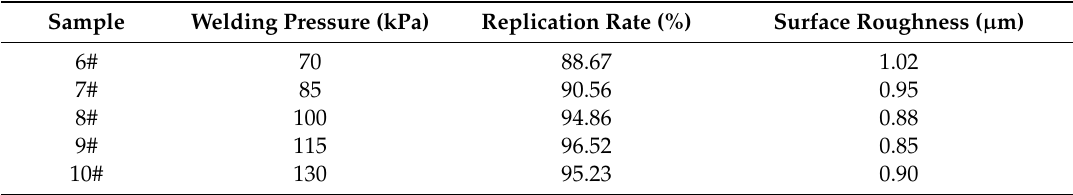
Figure 6. The replication rate of micro-structure at di ff erent welding pressures and three-dimensional profile: ( a ) 70 kPa; ( b )85 kPa; ( c ) 100 kPa; ( d ) 115 kPa; ( e ) 130 kPa. Table 3. Replication rate and surface roughness of micro-structured part fabricated under di ff erent welding pressures.